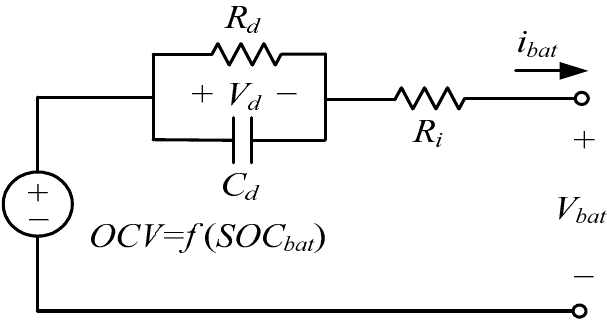
Figure 2. Battery voltage response during the pulse current.